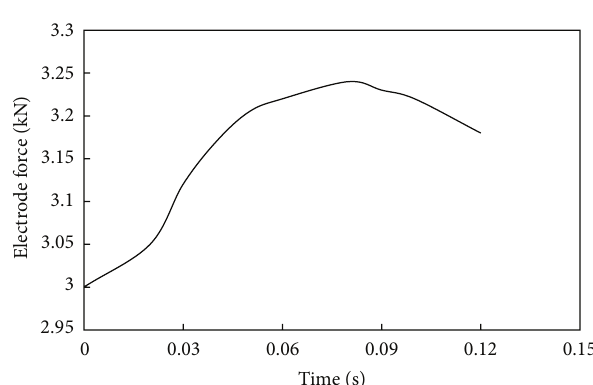
Figure 8: Typical electrode force curve with